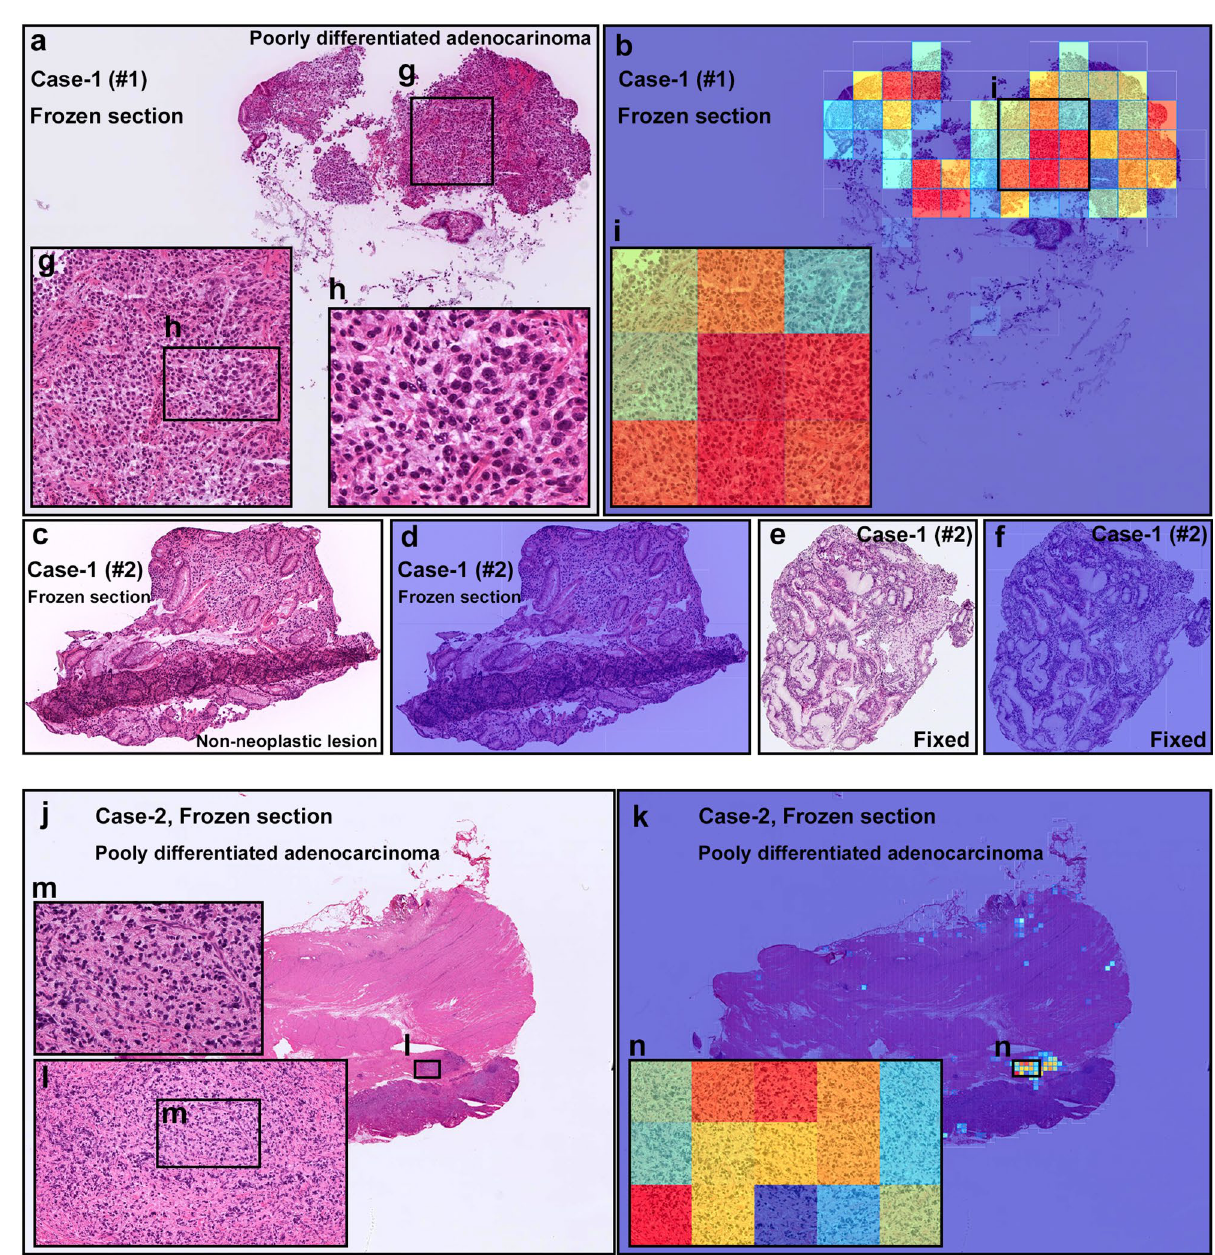
Figure 7. Representative two cases of frozen section specimens for diffuse-type differentiated ADC. Case-1 consisted of two specimens (#1 and #2). In Case-1 (#1) ( a ), the heatmap image ( b ) shows true positive predictions of diffuse-type differentiated ADC cells ( g – i ). In Case-1 (#2) frozen section specimen ( c ), there was no cancer cells indicating non-neoplastic specimen which was corresponded to the heatmap image ( d ). The frozen section (#2) was double-checked after conventional fixation ( e ). No cancer cells were observed in the fixed specimen as well ( e ) which was corresponded to the heatmap image ( f ). In Case-2 ( j ), the heatmap image ( k ) shows true positive predictions of diffuse-type differentiated ADC cells ( l – n ). Model applied at × 20, where 2 the 224 × 224px heatmap square represents 112 × 112 µ m